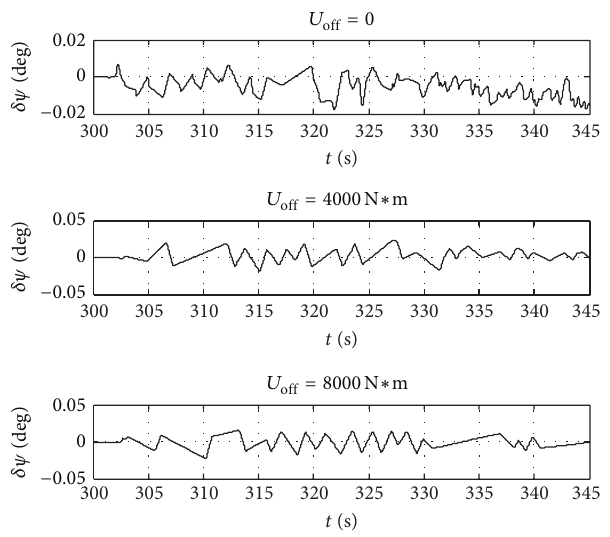
Figure 26: Simulation result of yaw angle deviation.